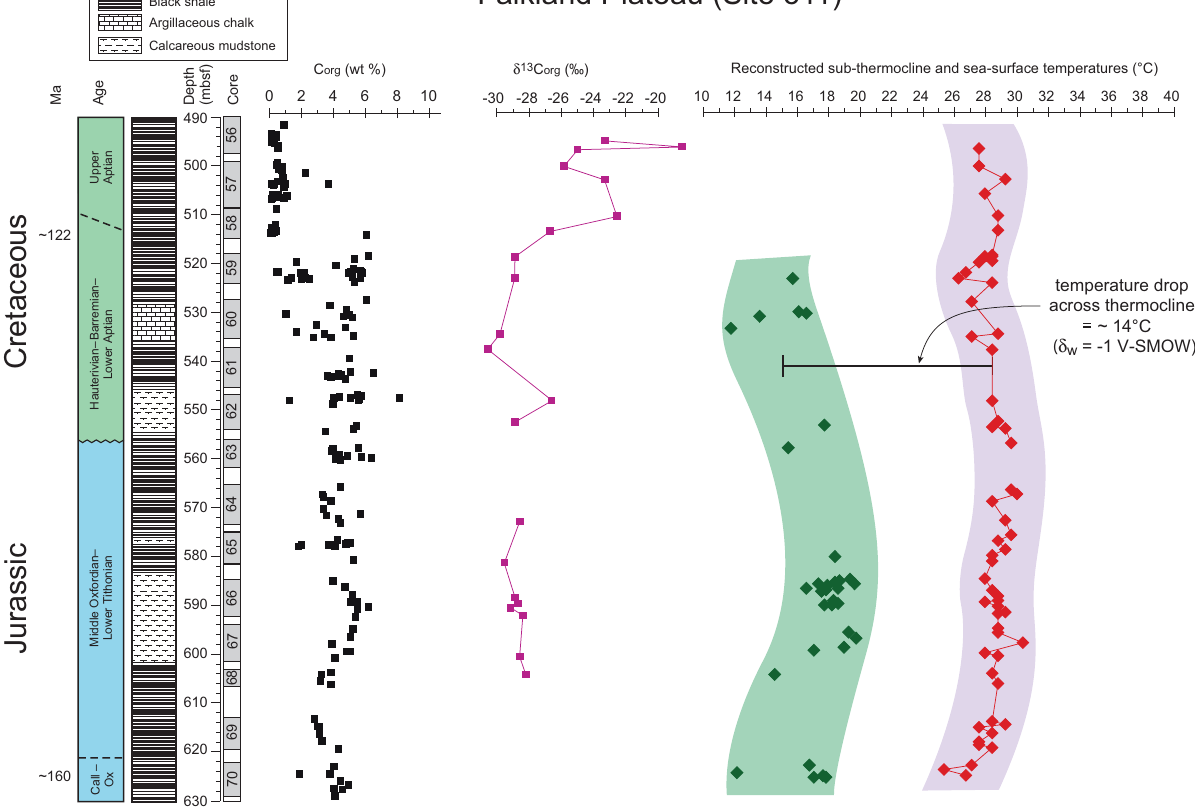
Fig. 3. Geochemical and palaeotemperature data from DSDP Site 511 on the Falkland Plateau. TOC data after Deroo et al. (1983); belemnite δ 18 O palaeotemperature determinations after Price and Gr¨ocke (2002); TEX 86 palaeotemperatures derived from the equation of Kim et al. (2010). Biostratigraphy after numerous sources (see text) integrated with strontium-isotope stratigraphy (Price and Gr¨ocke, 2002). The relatively low values of δ 13 Corg passing to relatively high values in the higher parts of the cored section are characteristic of the Aptian stage. The position of the sediments recording the OAE (Fig. 4) is fixed by biostratigraphy (Bralower et al., 1993), as well as by the carbon- isotope curve (negative to positive excursion) and the stratigraphic pattern of enrichment in organic carbon, which shows a dramatic fall in the 520–510mbsf level. The Jurassic part of the section displays an overall warming trend, the Cretaceous part of the section an overall cooling trend; the estimated temperature change across the thermocline is similar through both intervals. Approximate absolute ages after the time scale of Ogg et al. (2008): given points are based on the Callovian-Oxfordian boundary and the early Aptian